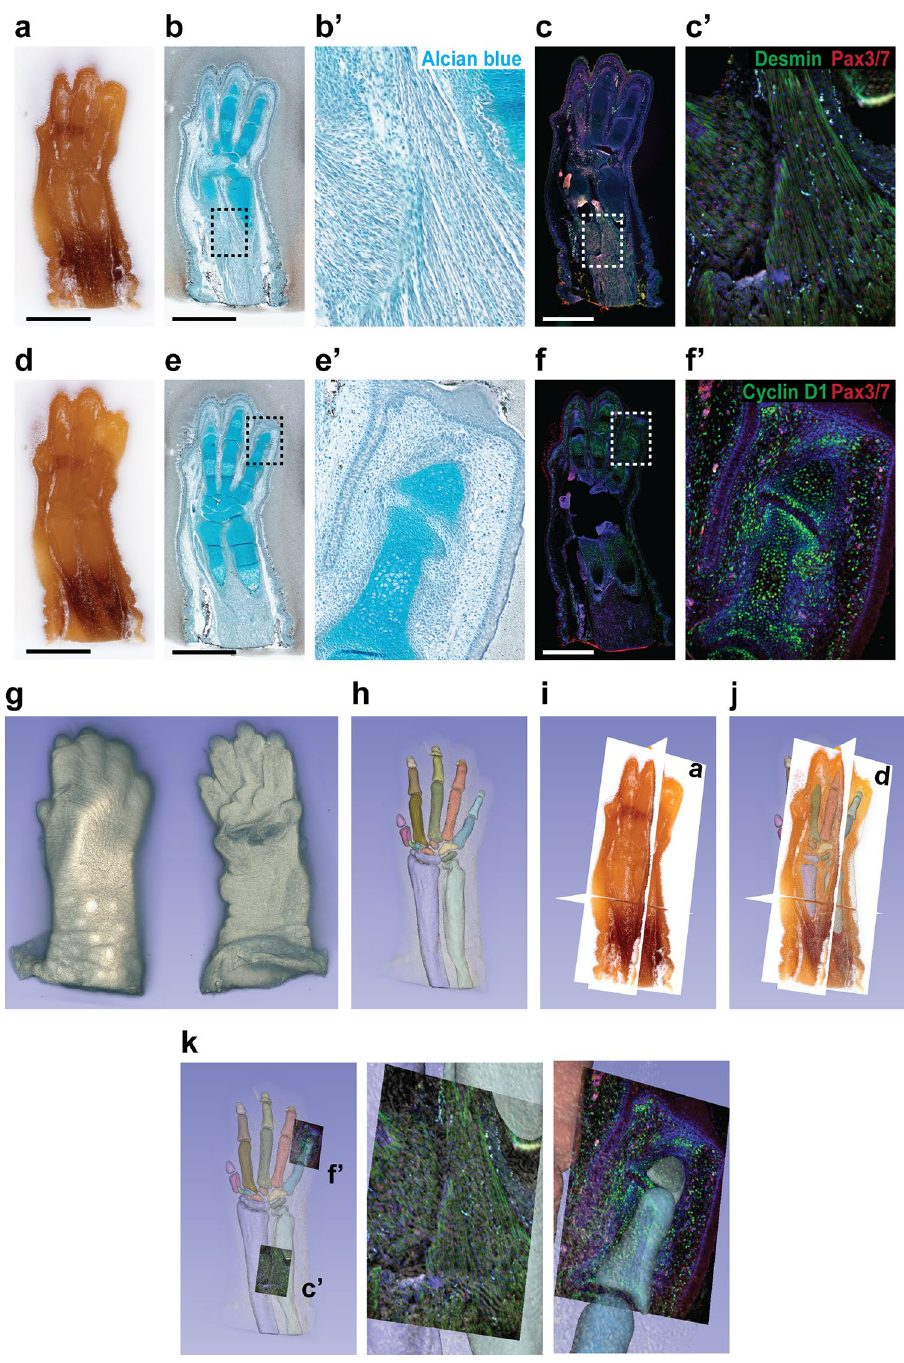
Figure 5. Usability of CoMBI data. Mouse forelimb on E16 were pre-embedded in white-agarose and embedded in paraffin. The 267-serial block-face images with 6-µm interval were obtained. ( a – f ) After imaging the 2 block faces shown in ( a ) and ( d ), 2 serial sections were collected and used for Alcian blue staining ( b , e ) or immunostaining ( c , f ) for desmin (green in c ), cyclin D1 (green in f ), Pax3/7 (red in c , f ). Nuclear DNA was labeled with DAPI (blue in c , f ). Boxed areas in ( b , c , e , and f ) are shown at higher magnification ( b ′ , c ′ , e ′ and f ′ ). ( g ) Volume-rendered image. ( h ) Segmentation of cartilages. ( i , j ) Orthoplanes. Planes labeled with ( a ) and ( d ) are identical to block faces shown in ( a ) and ( d ). Segmented cartilage and 3D image by volume rendering are also displayed ( j ). ( k ) Fluorescent micrographs in ( c ′ ) and ( f ′ ) are shown in the original location. Bars: 1